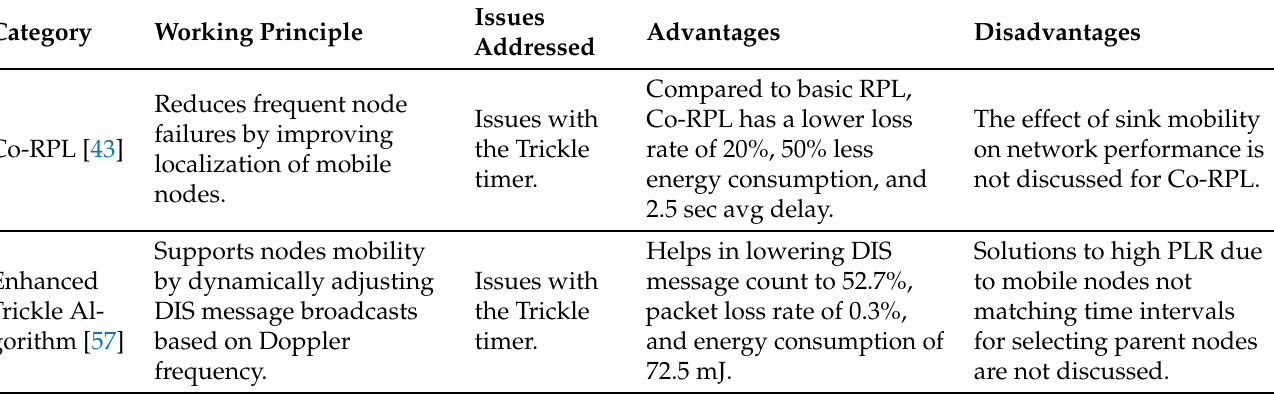
Table 1. Summary of Trickle Timer-based